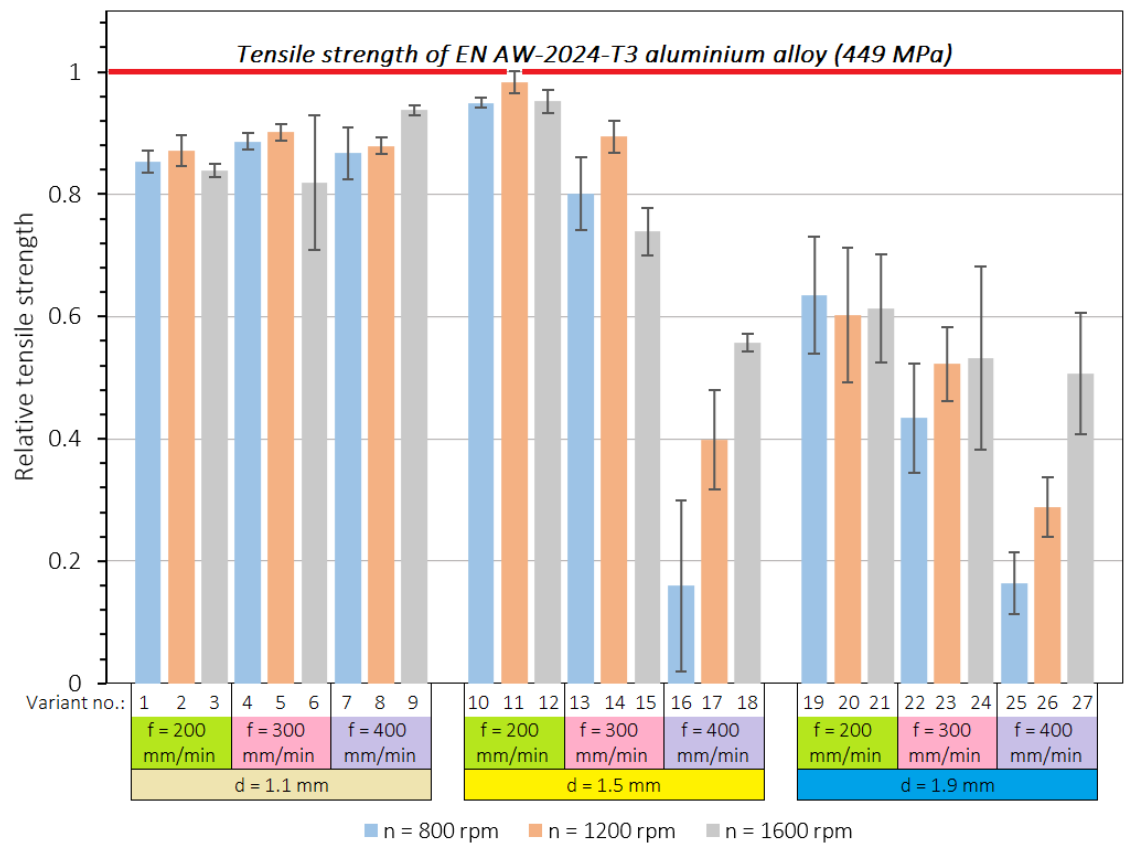
Figure 5. Effect of welding parameters on relative tensile strength.